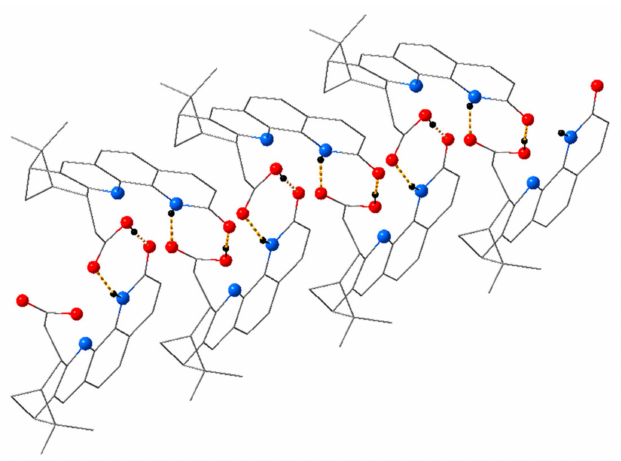
Figure 6. Hydrogen bonding pattern in the solid state structure of 6